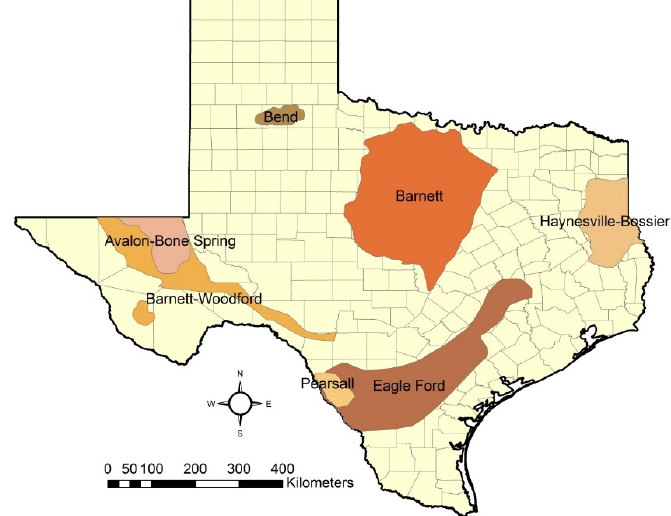
Figure 2. There are several shale plays in Texas: the Avalon-Bone Spring, Barnett, Barnett-Woodford, Eagle Ford, Haynesville-Bossier, and Pearsall shales. Most of these shales are in drought-prone areas. (Map created by the authors based on data from [21,22]).